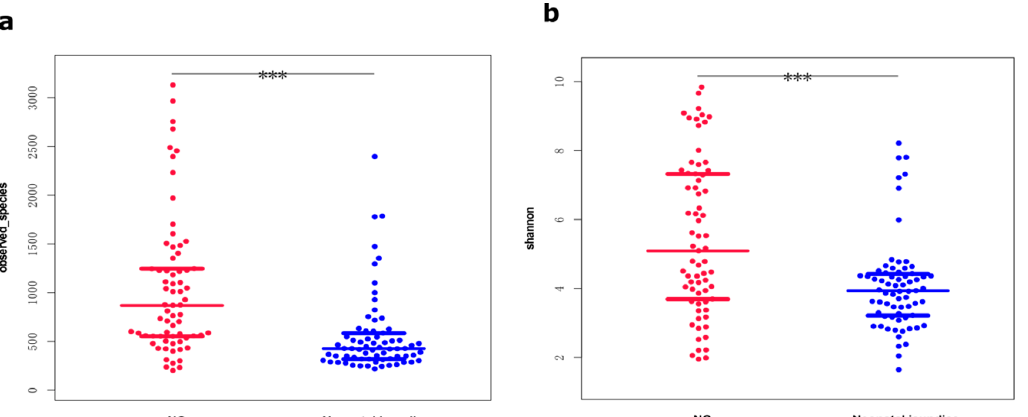
point represents one sample. ( a ) Species richness in the feces of neonates with jaundice and healthy controls; few samples in either group had >2000 microbial species. Most were <1000, and the NJ group had significantly fewer gut microbes. ( b ) Diversity of fecal microorganisms in both groups. The vertical coordinate represents the Shannon index, with larger values indicating a higher re- sponse biodiversity (i.e., more species meant that the samples were more evenly distributed). The fecal microbiota diversity was significantly lower in neonates with jaundice than in the controls. *, P value < 0.5,**, P value < 0.01,***, P value < 0.001.